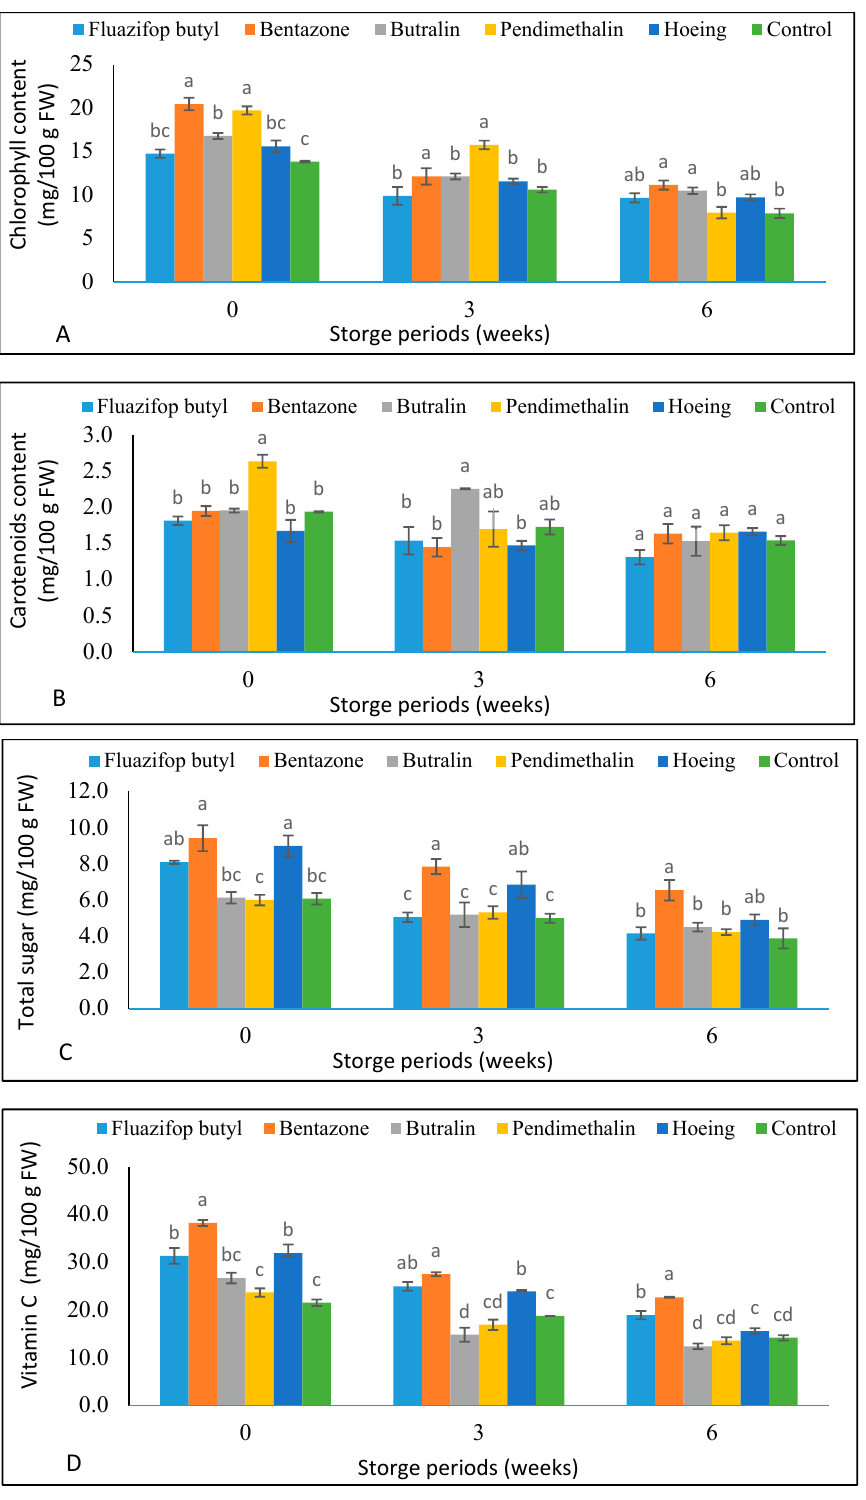
Figure 5. Effect of pre- and postemergence herbicides on pod weight loss % during cold storage at 4 °C for 45 days. Dif- ferent letters indicate significant differences between treatments (Duncan test at p < 0.05); vertical bars indicate standard error.